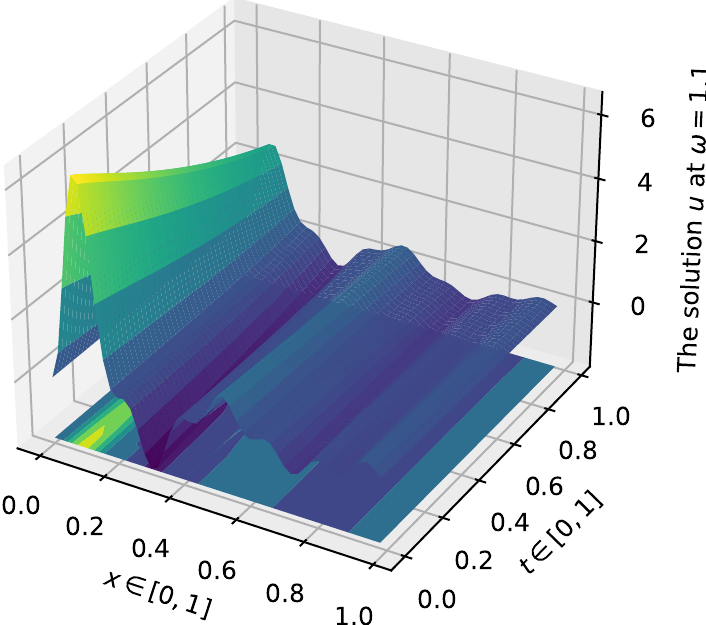
Figure 1. The 3-dimensional graph of solution u on the domain ( x , t ) ∈ [ 0,1 ] × [ 0,1 ] for ω =